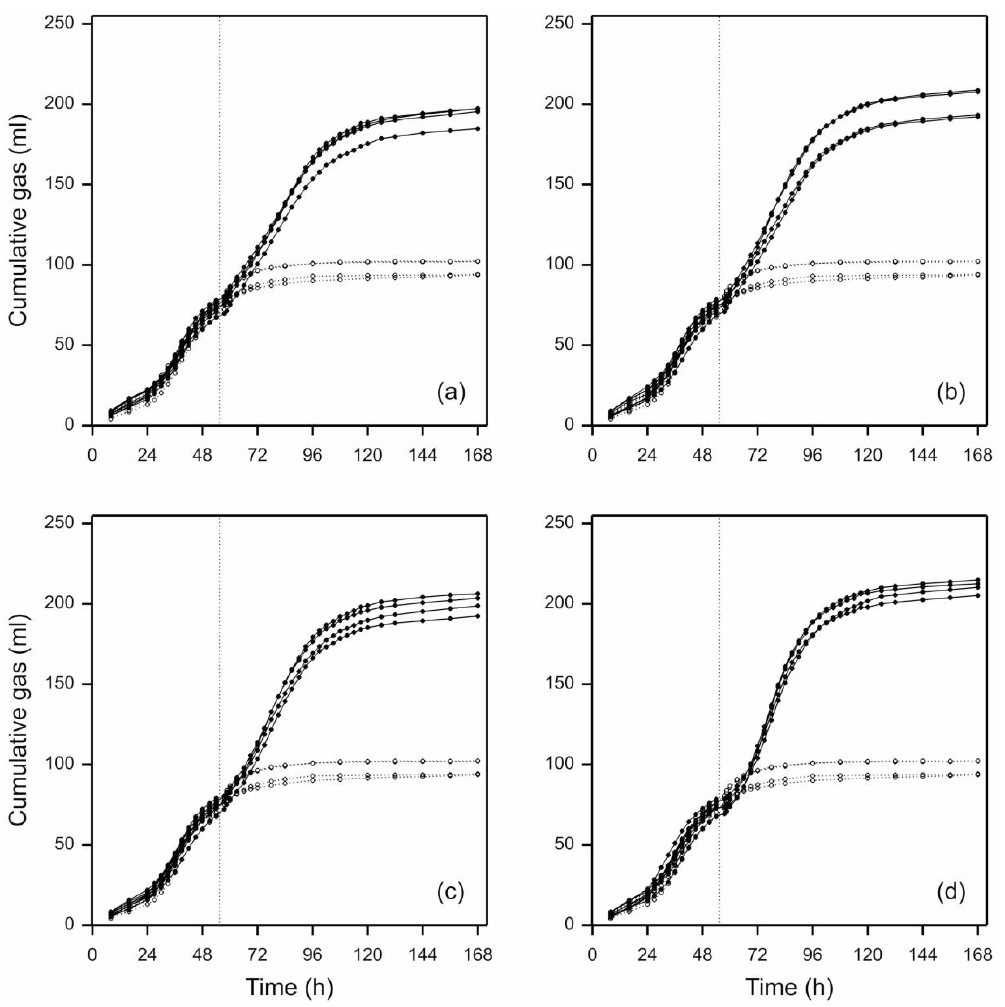
Figure 2. Individual total cumulative gas production profiles produced by N. frontalis cultures before and after addition of fresh perennial ryegrass of different cut-lengths: ( a ) 0.5 cm, ( b ) 1.0 cm, ( c ) 2.0 cm, ( d ) 4.0 cm; black lines. Dotted black lines with open symbols in each panel indicate cumulative gas production profiles for control bottles which had no leaf-blades added. The vertical grey dotted lines indicate the time of leaf-blade addition (at 54 h). Four individual bottles are plotted for each particle length, and three for the control (due to an outlier bottle being removed).